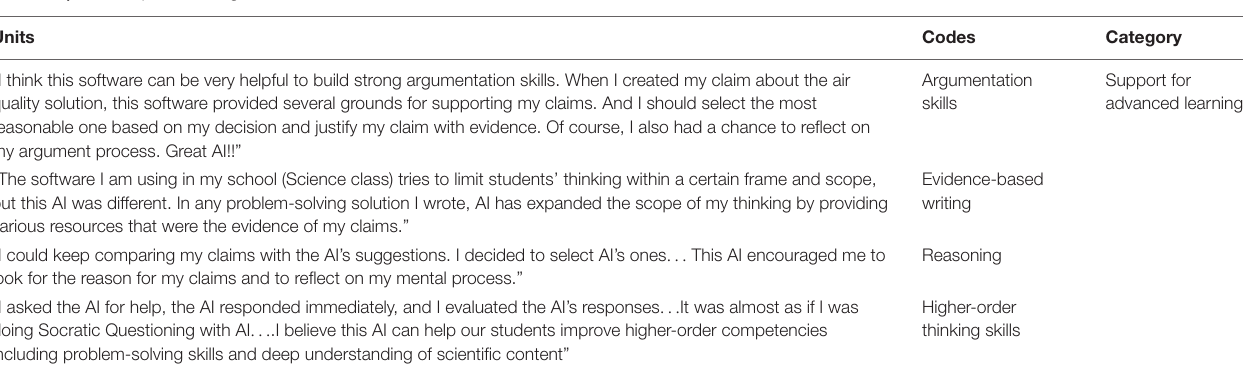
FIGURE 3 | Example of scaffolding in AISS. TABLE 2 | An example of